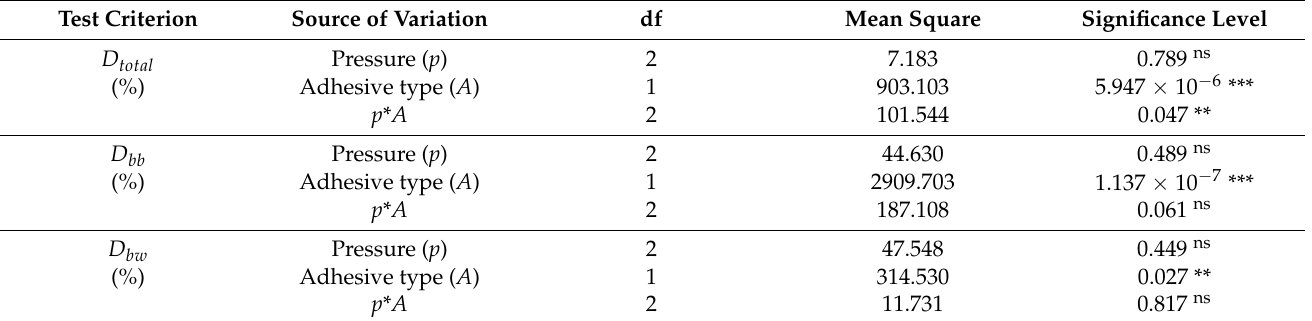
Figure 7. Delamination results for different configurations of CLBT: ( a ) delamination of CLBT spec- Figure 6. End and side views of specimens after delamination. imens, ( b ) the trend of delamination of CLBT specimens.